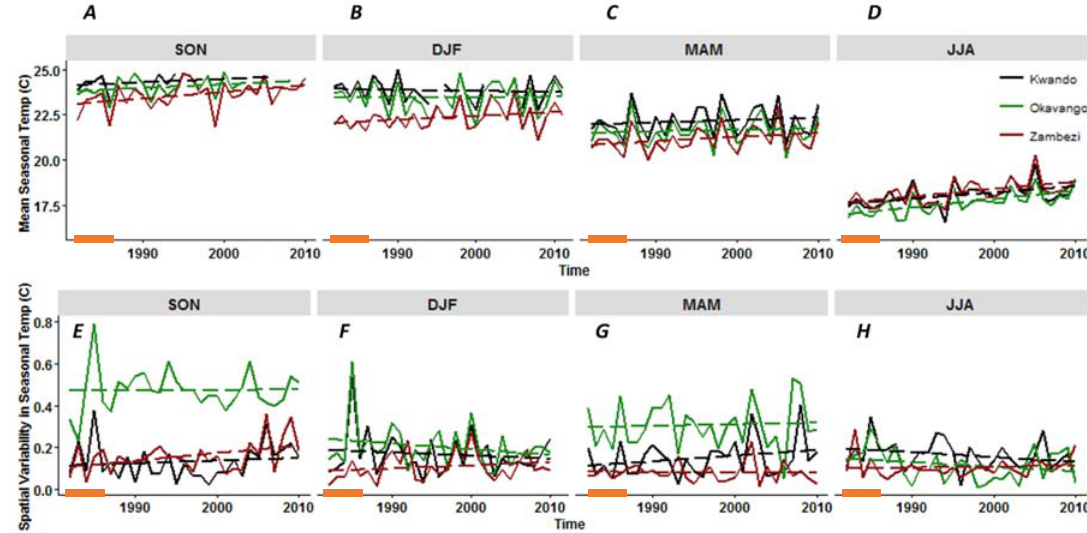
Figure 3. Seasonal mean ( A – D ) and standard deviation ( E – H ) of temperatures in degrees C across the Okavango, Kwando, and Zambezi from 1982–2010. The thick orange line at the bottom of each figure represents the seasonal baseline period used for the persistence analysis.